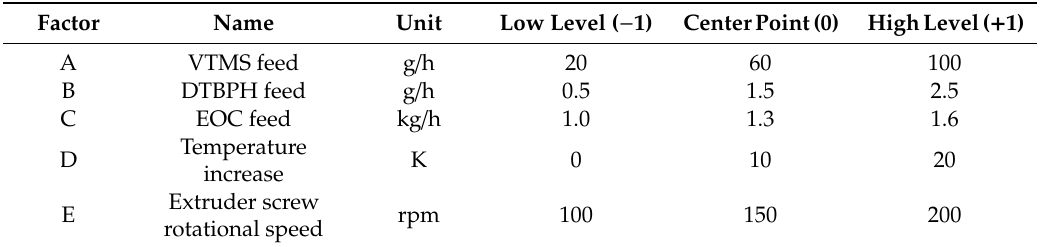
Table 1. Factors studied and factor levels used in the face-centered experimental design (FCD).